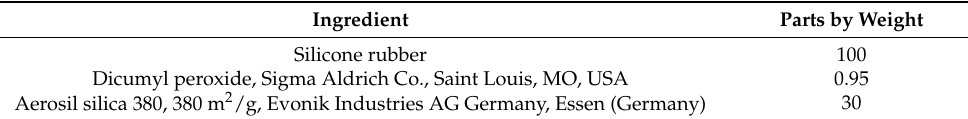
Table 2. Composition of rubber mixes containing silicone rubber (MVQ).